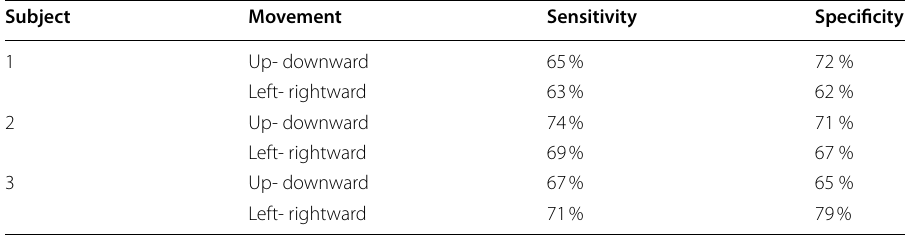
Table 4 Sensitivity and specificity